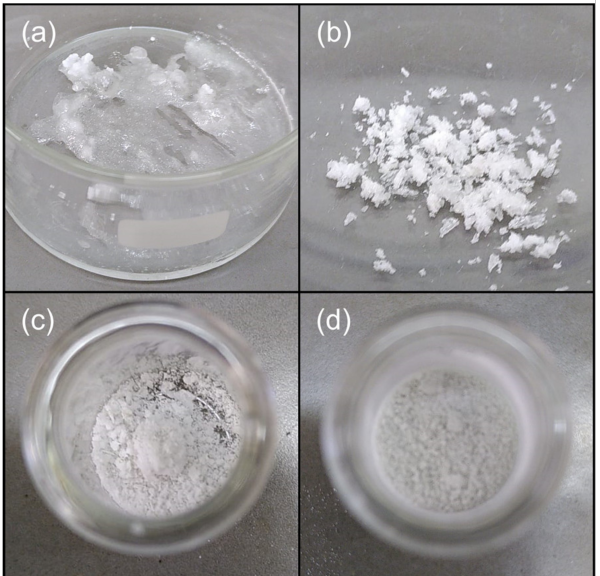
Figure 6. Comparison of 3 products received by solution and grinding crystallization: ( S )-3-MA • H 2 O three days of drying at ambient temperature after removal from mother liquid ( a ), and produced mechanochemically ( c ), ( rac )-3-MA three days of drying at ambient temperature ( b ), and ( rac )-3-MA after grinding ( d ).